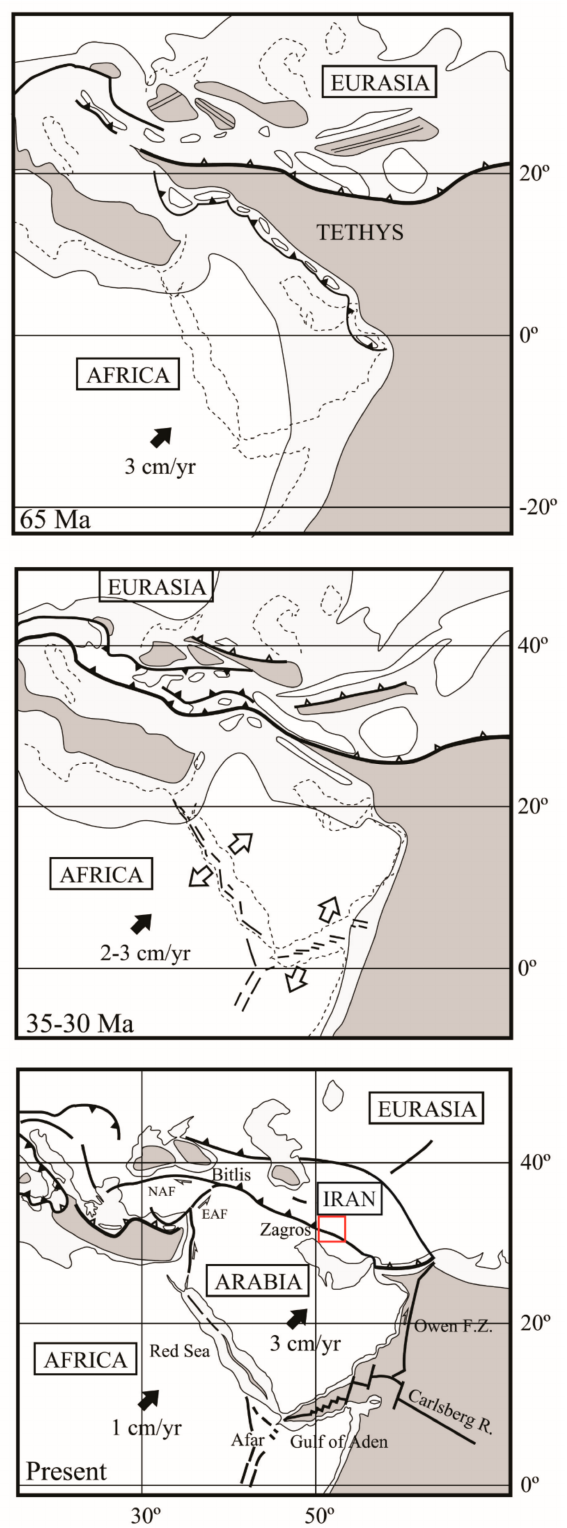
Figure 1. Cenozoic plate tectonic evolution of the Iranian, Arabian, NE African, and south of Eurasian plates, at 65, 35–30 Ma, and present-day ages (modified after [38]). Dark gray regions represent oceanic crusts and white regions represent continents. Empty arrows are the direction of extension. Black arrows are absolute velocities [39]. The red square in the present-day configuration of the plates shows the location of Figure